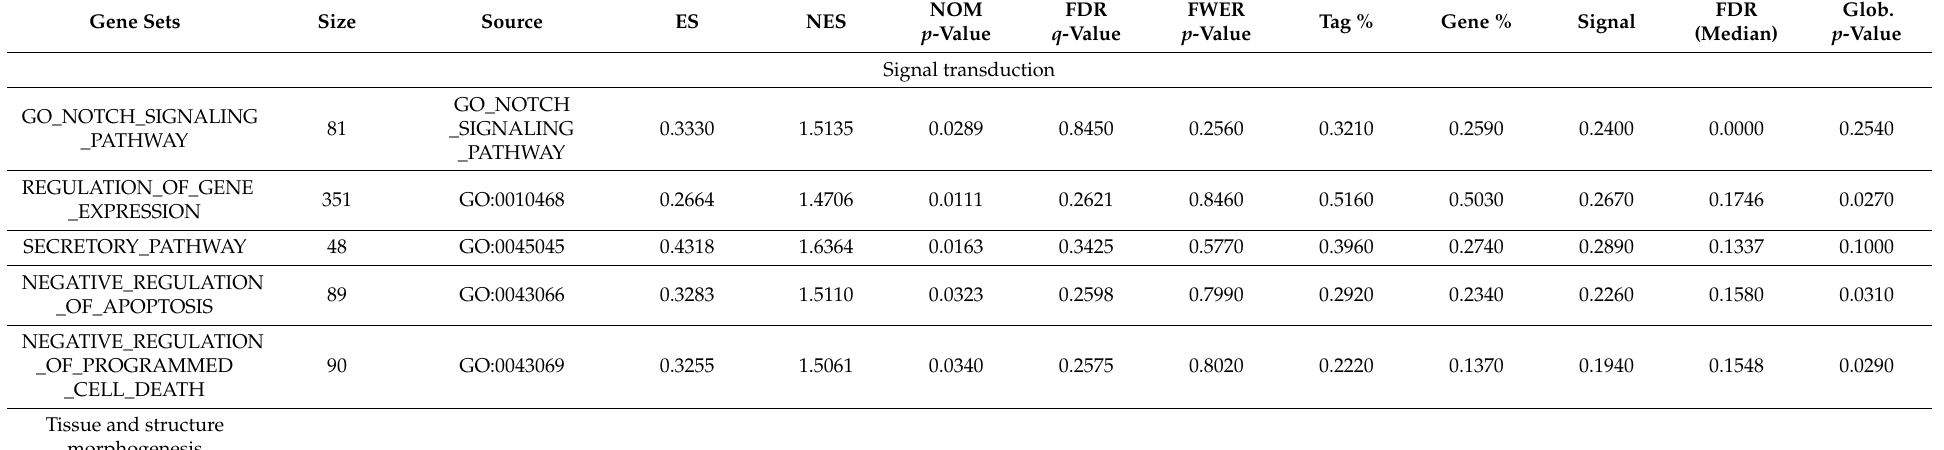
Table 6. Gene sets differentially overrepresented in lung cancer patients vs. healthy